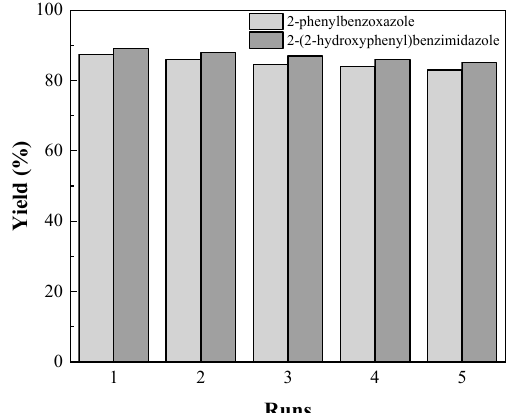
Figure 7. Recyclability of F,O,S ‐ codoped g ‐ C 3 N 4 for the synthesis of 2 ‐ phenylbenzoxazole and 2 ‐ (2 ‐ hydroxyphenyl)benzimidazole.